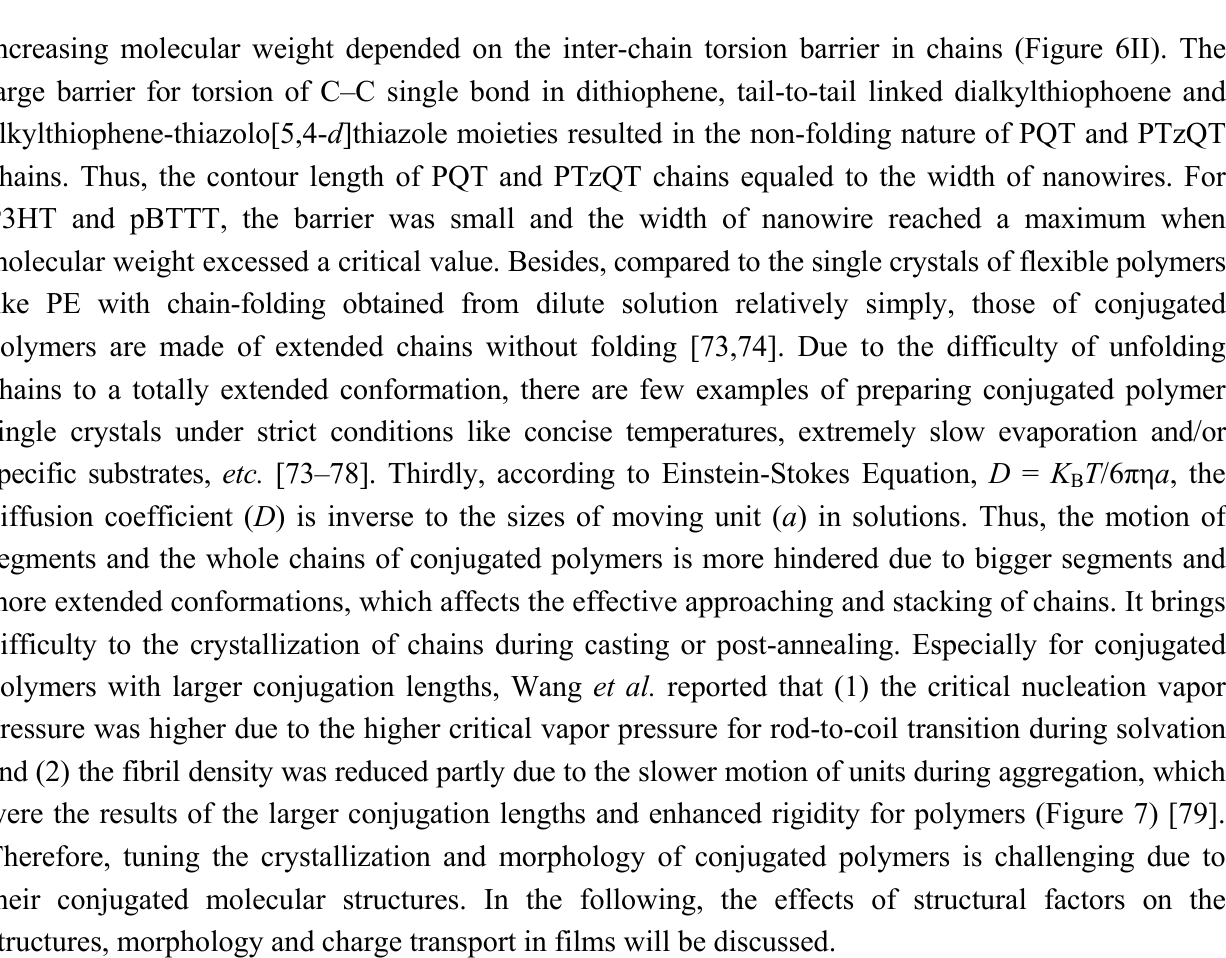
Figure 5. ( a ) The conformations of regio-regular P3HT (rr-P3HT) and regio-random P3HT (rra-P3HT) shown omitting side-chains, (Adapted with permission from [69]. Copyright 2011 American Chemical Society) and ( b ) the STM images of P3HT and P3DDT chains on HOPG surface with the corresponding schematic illustration of chain packing and chain-folding, (Adapted with permission from [70]. Copyright 2000 Wiley-VCH